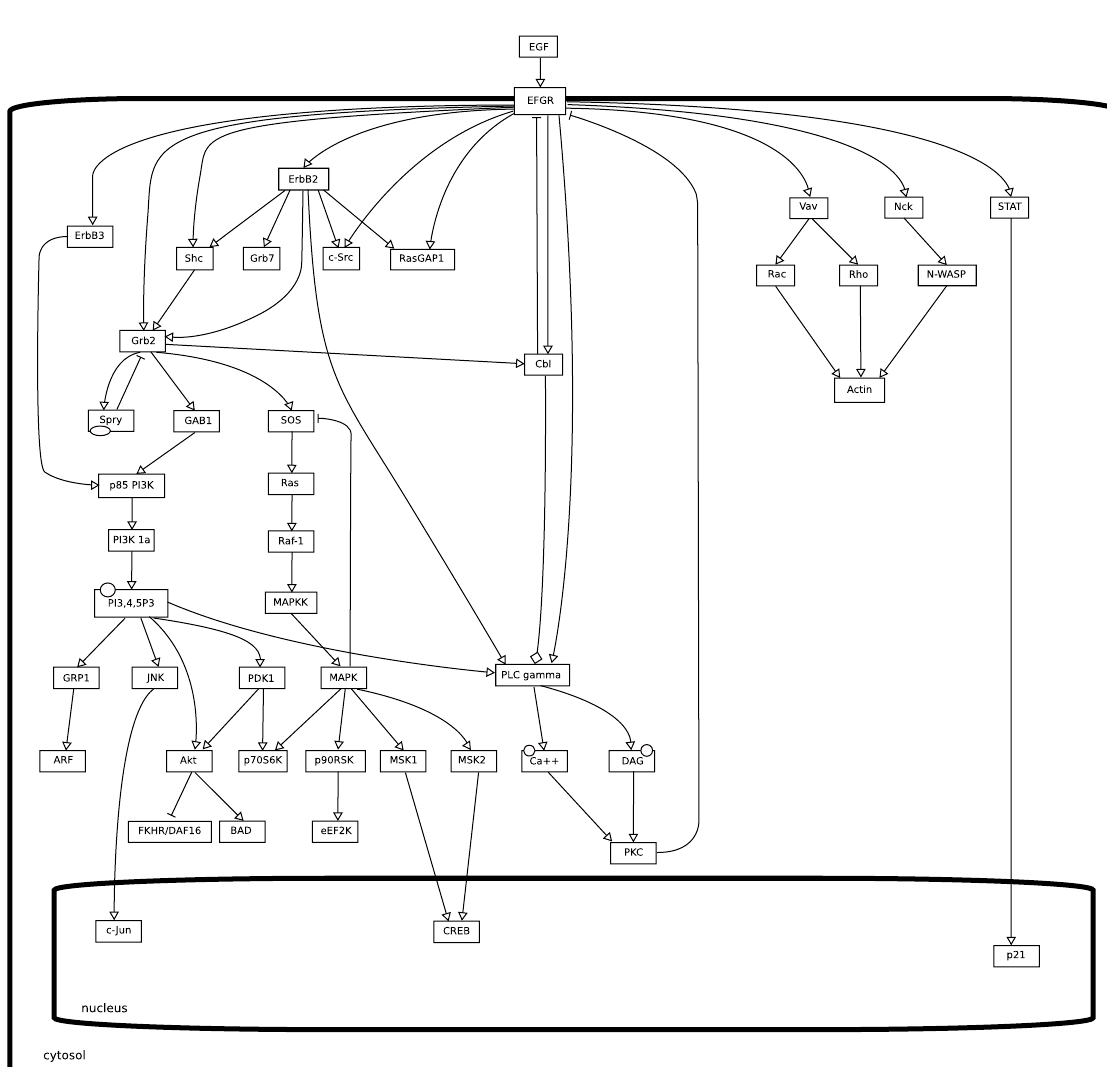
Figure A.2: Epidermal Growth Factor Receptor